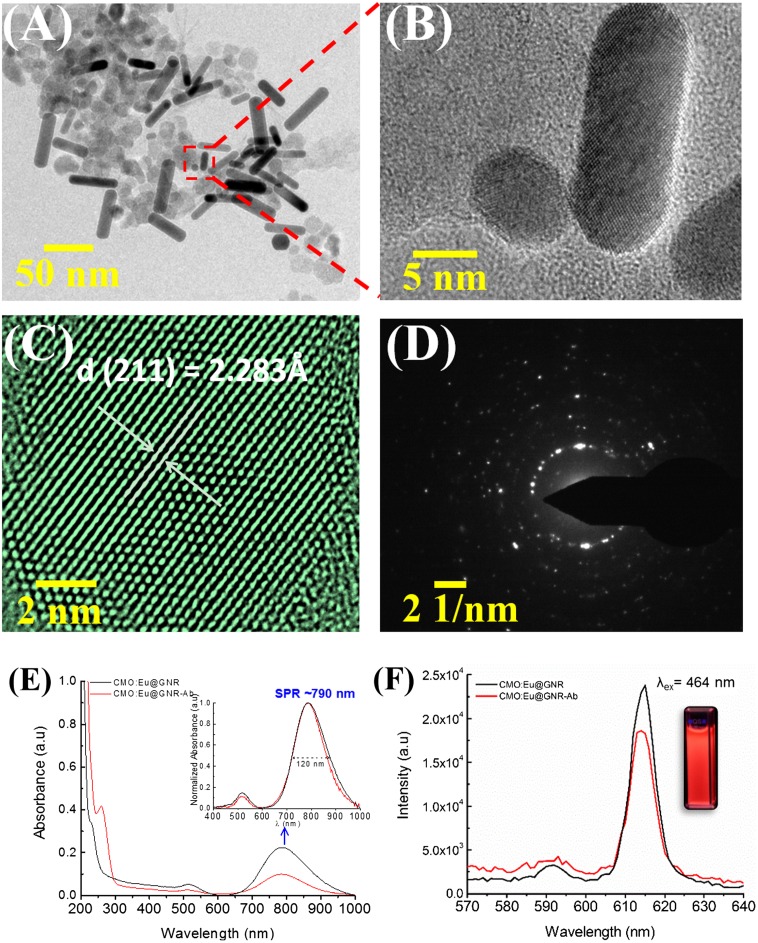
(A) TEM and (B) HRTEM images of CMO:Eu@GNR. (C) HRTEM image of CaMoO4:Eu NPs and (D) SAED pattern for (A). (E) UV–visible and (F) photoluminescence (λex = 464 nm) spectra of CMO:Eu@GNR without (black) and with Ab (red). Inset in (E) shows the comparison of normalized absorption spectrum at an SPR of 790 nm. Digital photograph of the CaMoO4:Eu NPs dispersed in PBS under a UV-lamp (λex = 254 nm), shown in the inset of (F).